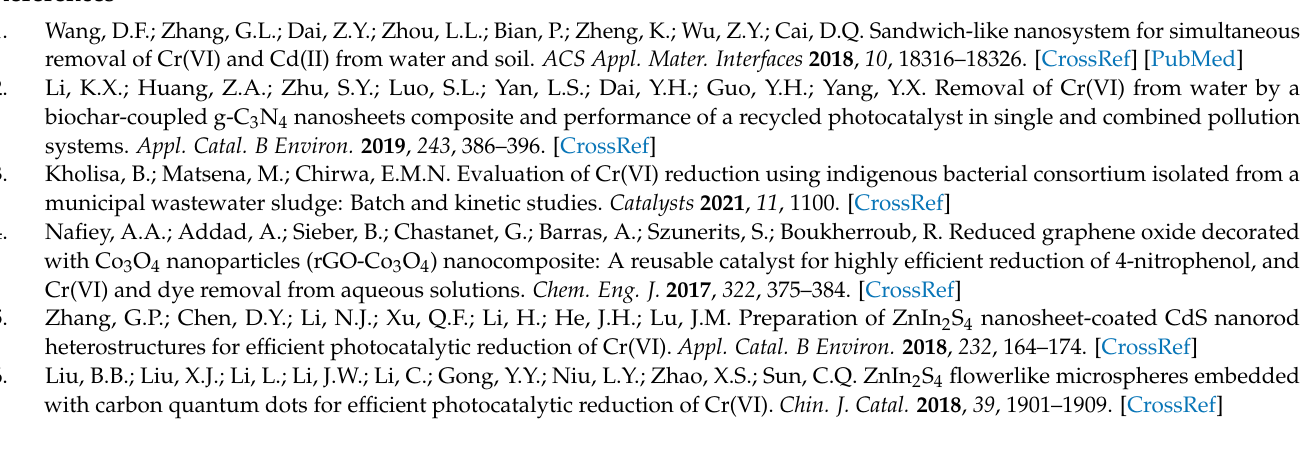
Figure S2: TEM (a) and HRTEM (b) of EG-120; Figure S3: Adsorption removal efficiencies of Cr(VI) by different ZnIn 2 S 4 in the dark; Figure S4: Photocatalytic removal efficiencies of Cr(VI) by EG-120 in the presence of different